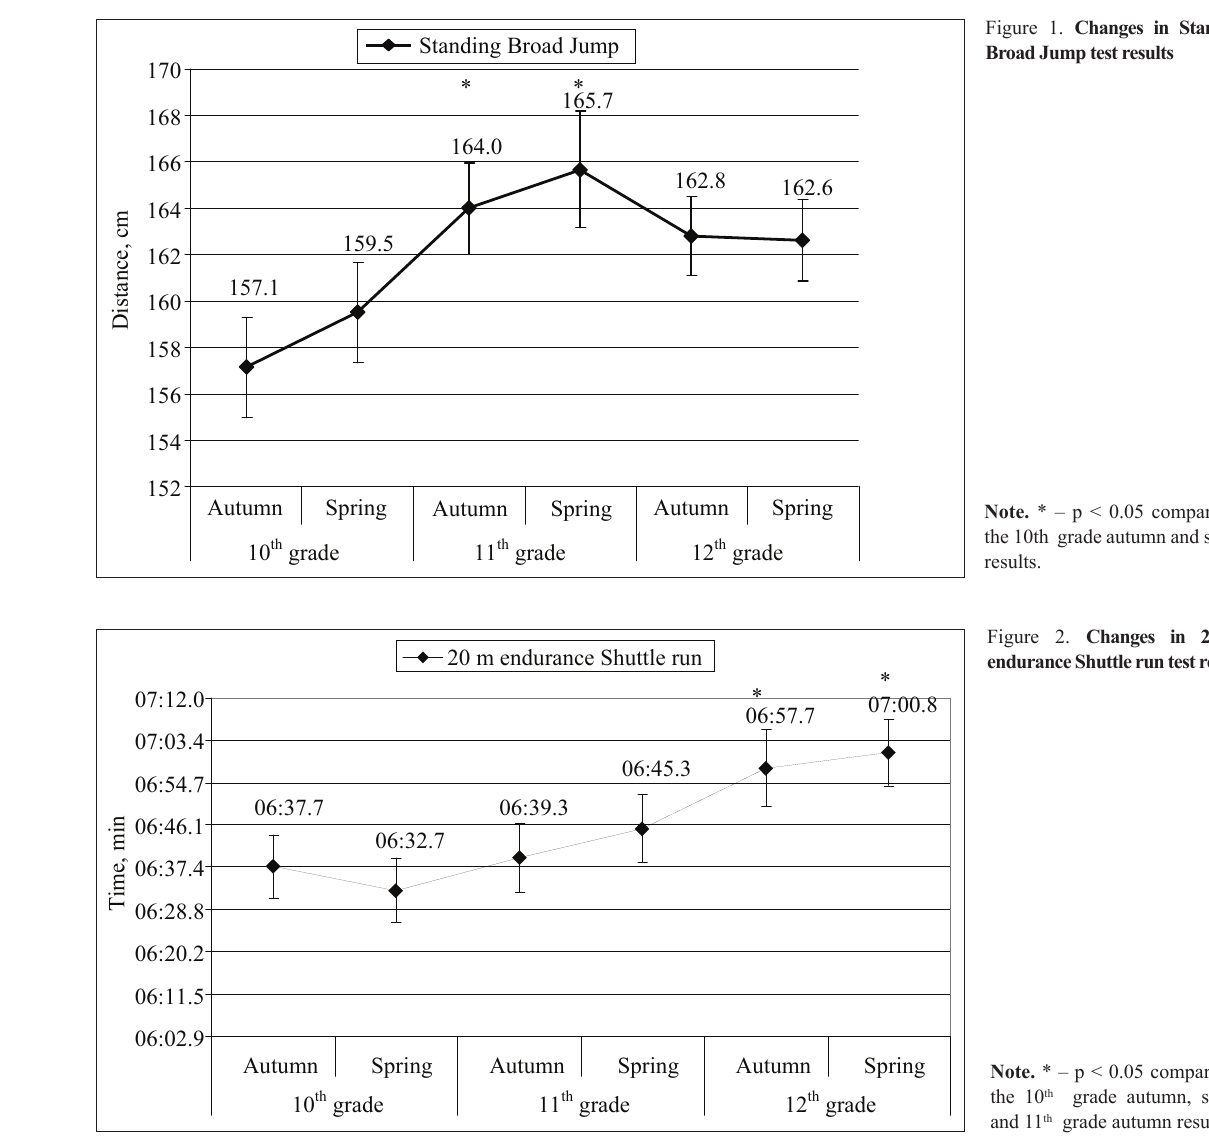
Figure 2. Changes in 20 m endurance Shuttle run test results